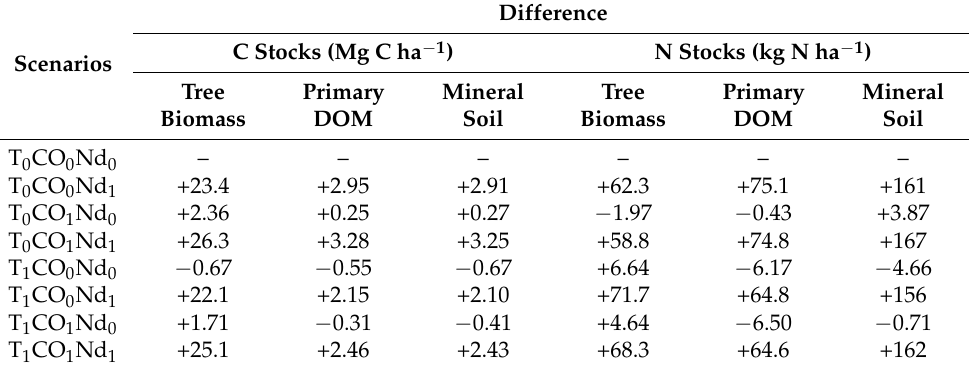
Table 3. The difference in the mean C and N stocks in 2020 across the South Korean forests as a result of increased level of temperature, CO 2 concentration, and N deposition. Abbreviations of scenarios are found in Table